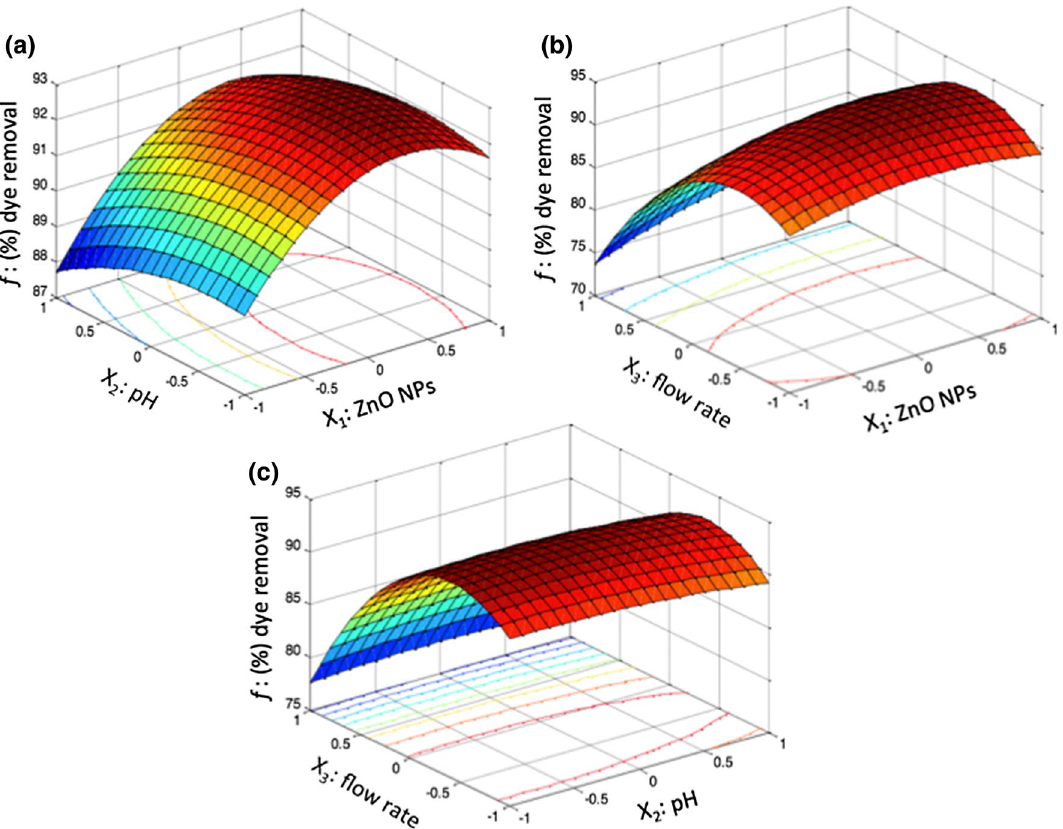
Fig. 8 Design-Expert plot, 3-D response surface corresponding to % dye removal and contour plot for: a ZnO and pH; b ZnO and flow rate; c pH and flow rate